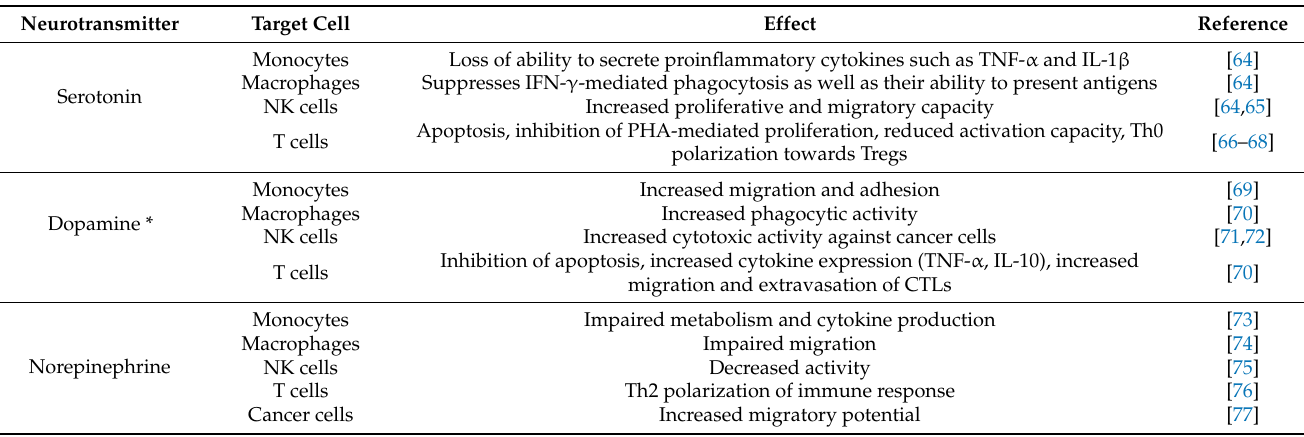
Table 1. Neurotransmitters and their effect on the immune